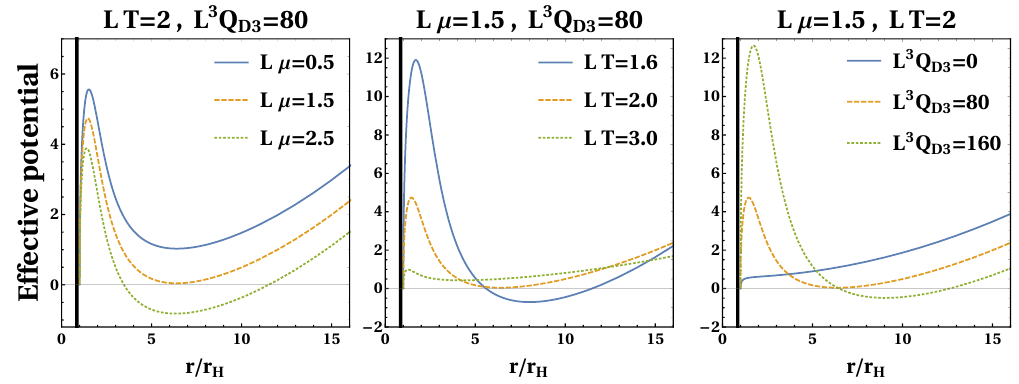
Figure 3 . Probe brane e(cid:11)ective potentials for k = 1 and all charges equal, varying the chemical potential (left), the temperature (center), and the angular momentum of the probe (right).